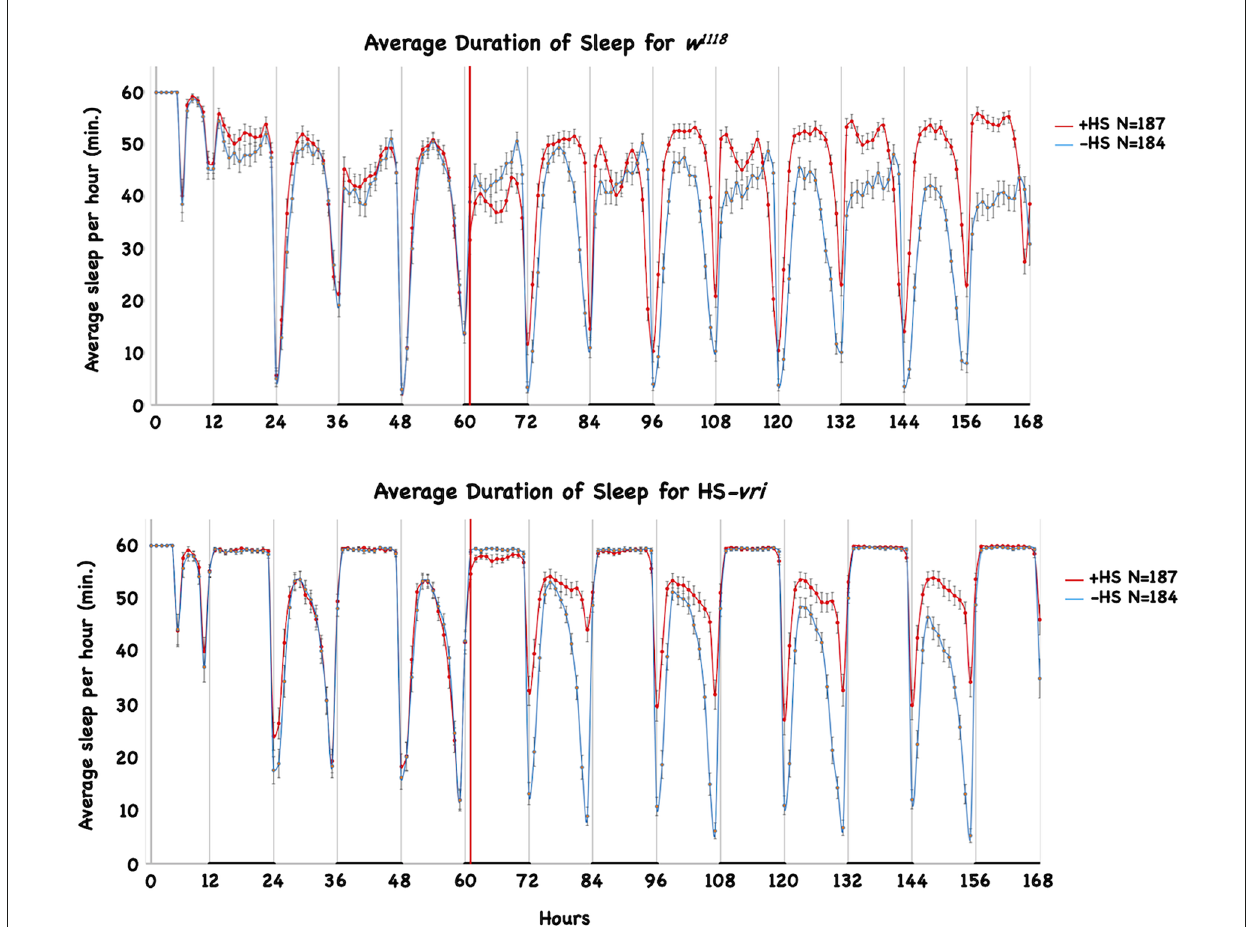
FIGURE4 Effect of HS- vri induction on sleep architecture. The effect of induction on sleep architecture was measured for four different groups ( w 1118 and HS- vri males, pre- and post-induction). The average minutes of sleep/hour is plotted as a function of elapsed time. For both genotypes, sleep was measured under 12-h light:12-h dark conditions, indicated with the white and black horizontal bars. Flies were entrained to a 12:12 schedule and then loaded into the DAMS monitors maintained in two different 20 ◦ C incubators with identical settings. Baseline sleep was assayed for 2 days before one of the incubators was shifted to 28 ◦ C and sleep measurements continued for flies at both temperatures. The timing of the heat-shift is shown with the dotted horizontal line. The blue and red curves represent the amounts of sleep for the non-induced and induced flies